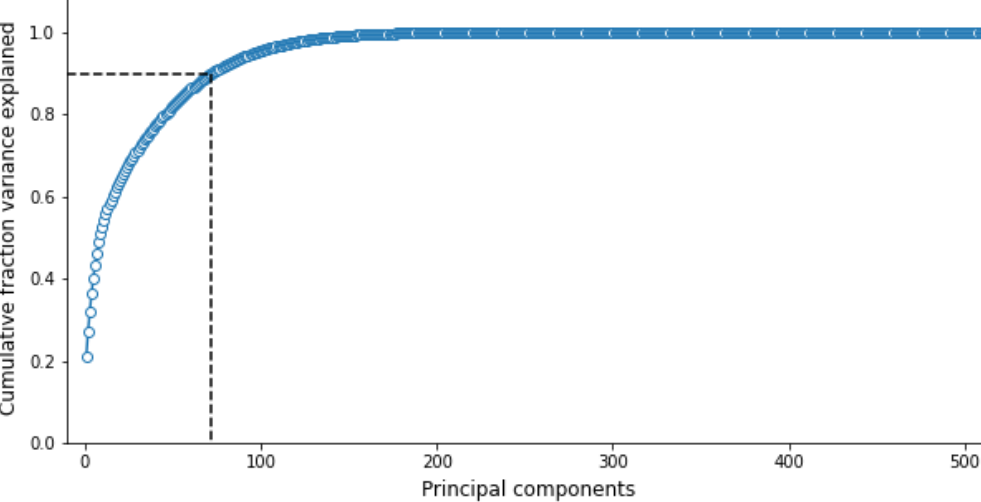
Table 2. Monitoring results on simulated dataset using Method